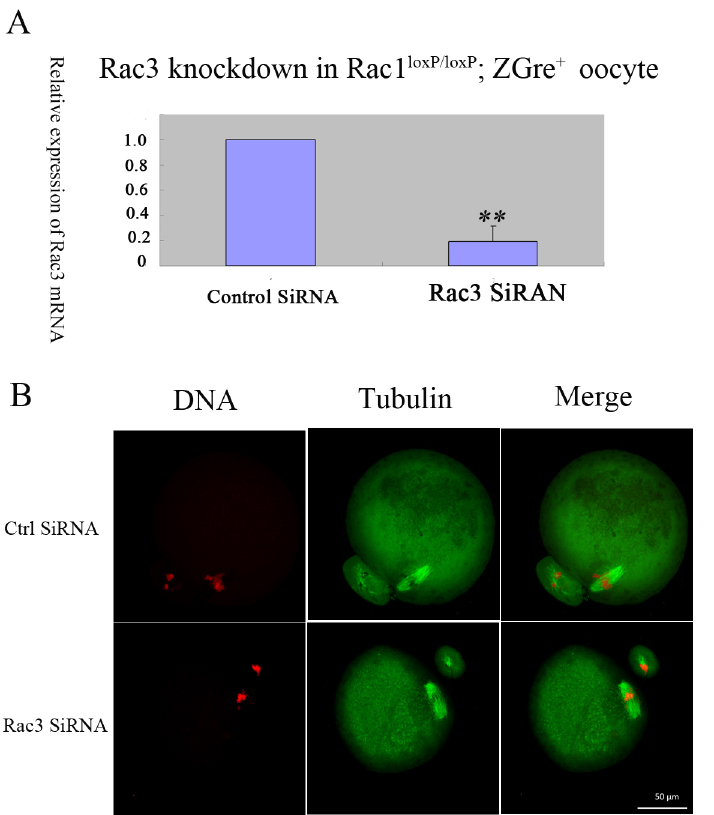
Fig 4. Knockdown of Rac3 has no effect on Rac1 loxP/loxP ; ZCre + oocyte maturation. (A) Knockdownof Rac3 through RNA interference in Rac1 loxP/loxP ; ZCre + oocytes. The Rac1 loxP/loxP ; ZCre + oocytes were microinjected control SiRNA or Rac3 SiRNA, incubatedin M16 medium with 2.5 μ MMilrinone for 24 hours, and then were collectedfor qRT-PCR. The experiments were repeatedat least three times. ** P < 0.01.(B) Normal MII eggs matured from Rac3-knockdowned- Rac1 loxP/loxP ; ZCre + oocytes. The control SiRNA or Rac3 SiRNA was microinjected into Rac1 loxP/loxP ; ZCre + oocytes. The oocytes were incubatedin M16 medium with 2.5 μ MMilrinonefor 24 hours, then were culturedin M16 medium, and the MII eggs were collectedfor immunofluorescent staining.The experiments were repeatedfor three times, and the typical images were shown. Green, spindle;Red,chromosomes.Bar,50 μ